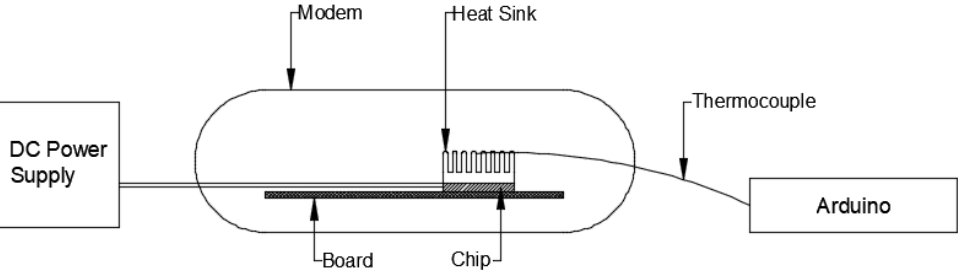
Figure 4. Schematic of the experiment.